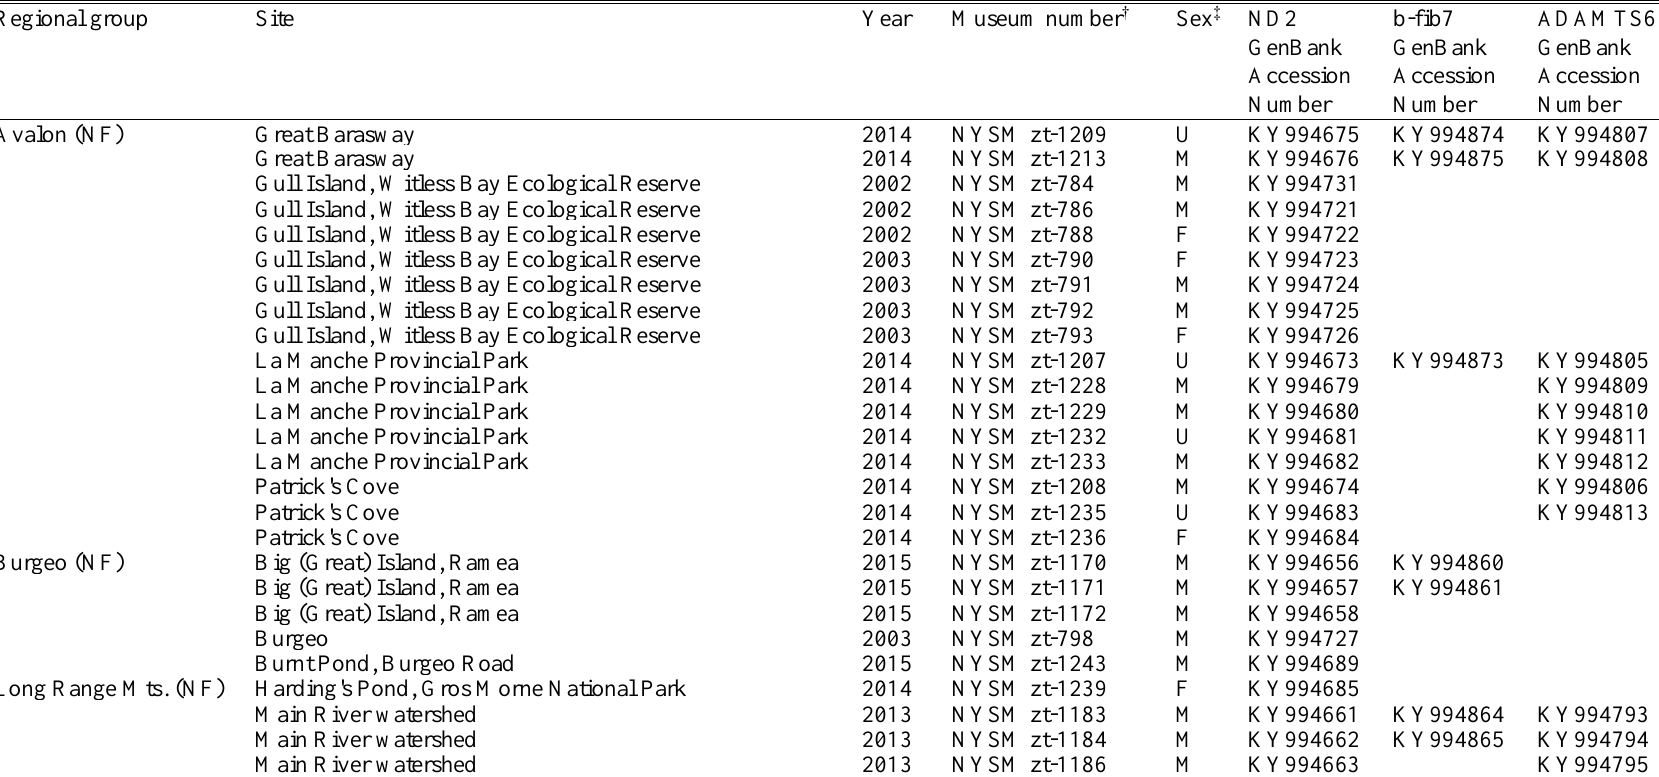
Table A1.1. Summary of Gray-cheeked Thrush ( Catharus minimus ) tissue samples collected in Newfoundland and Labrador, Canada, as well as additional Gray-cheeked Thrush and Bicknell’s Thrush ( C. bicknelli ) samples from elsewhere in Canada, the United States and Russia. Regional groups refer to those used in genetic comparisons within Gray-cheeked Thrush. The Hermit Thrush ( C. guttatus ) sample was used as an outgroup for coalescent analyses. GenBank sequence identification numbers may be accessed via www.ncbi.nlm.nih.gov/genbank/. However note that the sequences are being withheld on GenBank until May 1, 2018, to allow for publication of additional research by the